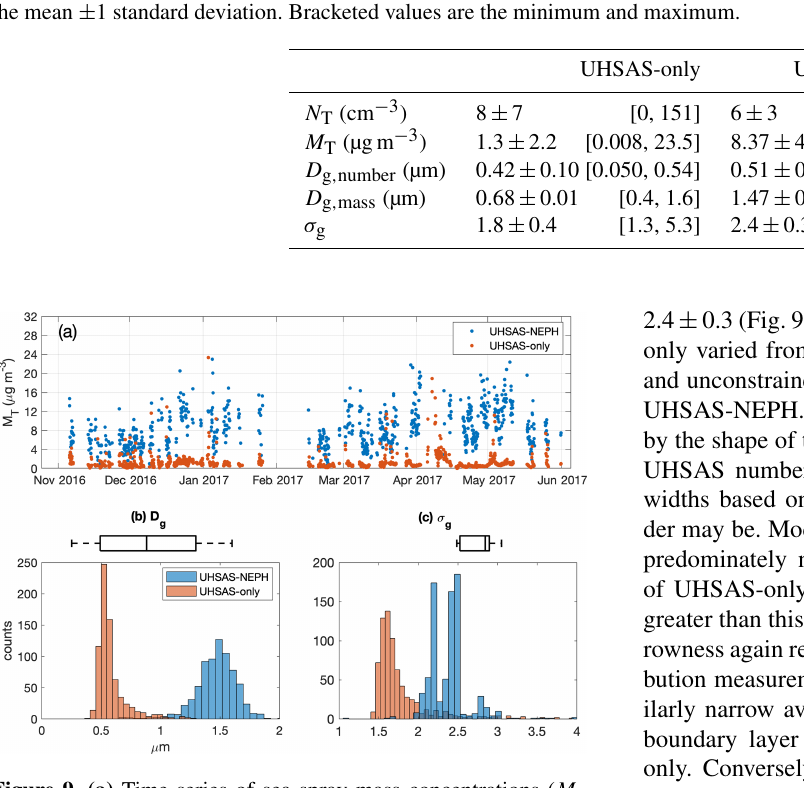
Figure 9. (a) Time series of sea spray mass concentrations ( M T , µgm − 3 ) retrieved from UHSAS-NEPH (blue) and UHSAS-only (orange) during clean marine periods of the LASIC background sea- son (see Table 5 for summary statistics). Histograms of the (b) ge- ometric mass mean diameter ( D g ) and (c) geometric standard de- viation ( σ g mode width) for the retrieved sea spray modes using UHSAS-NEPH and UHSAS-only. Box-and-whisker plots above the histograms represent the quartile ranges (25th and 75th percentiles) and median (vertical line) of sea spray mode fitting parameters re- ported in laboratory and field measurements (see Table